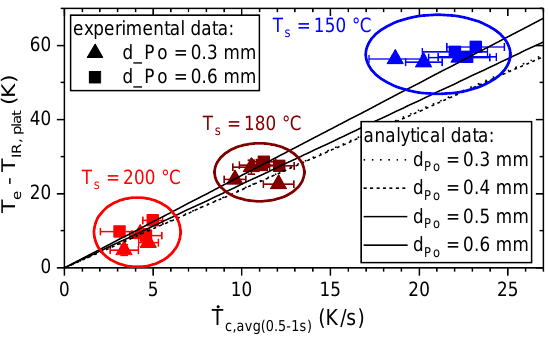
. T c , avg ( 0.5 − 1 s )